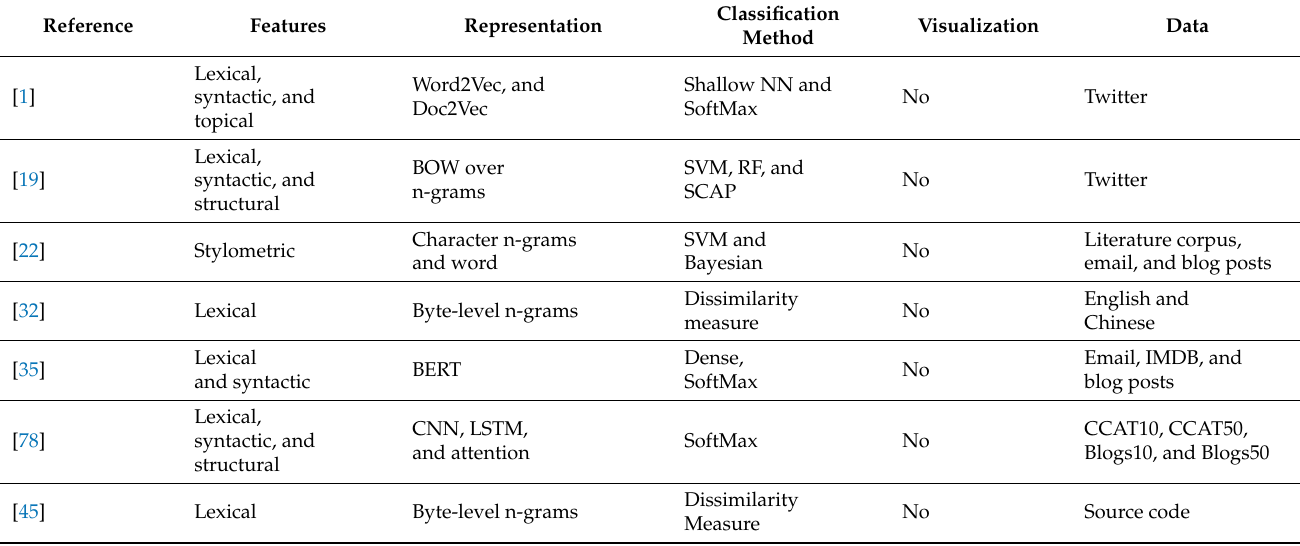
Table 1. Comparison of related studies based on common